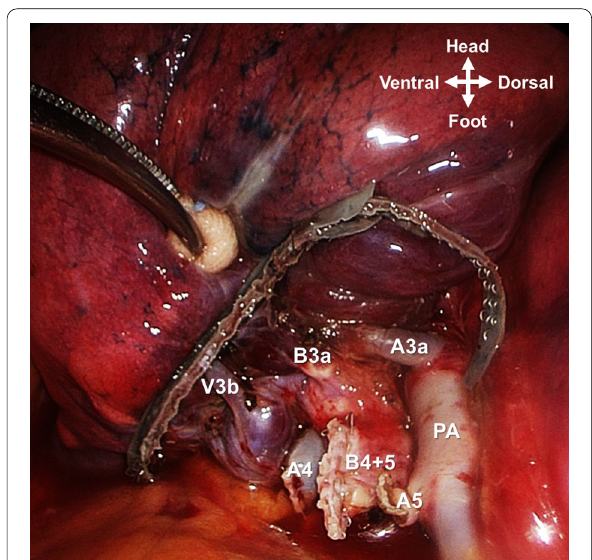
Fig. 4 Intraoperative view of the surgical field after extended lingulectomy. PA pulmonary